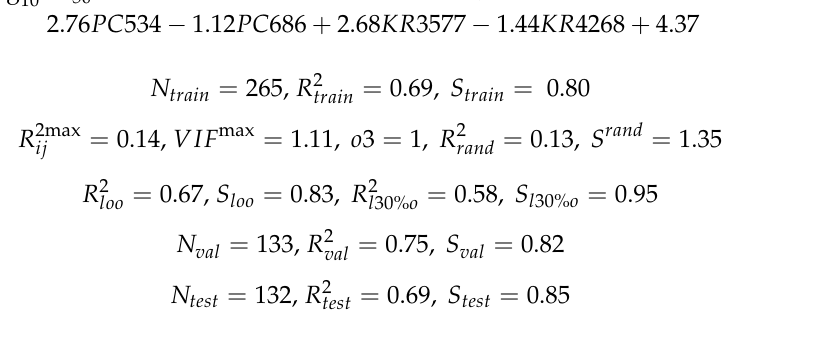
Table 1. Molecular descriptors involved in the best linear regression quantitative structure-activity relationship (QSAR) models for polo-like kinase-1 (PLK1) inhibitors. The selected model appears in